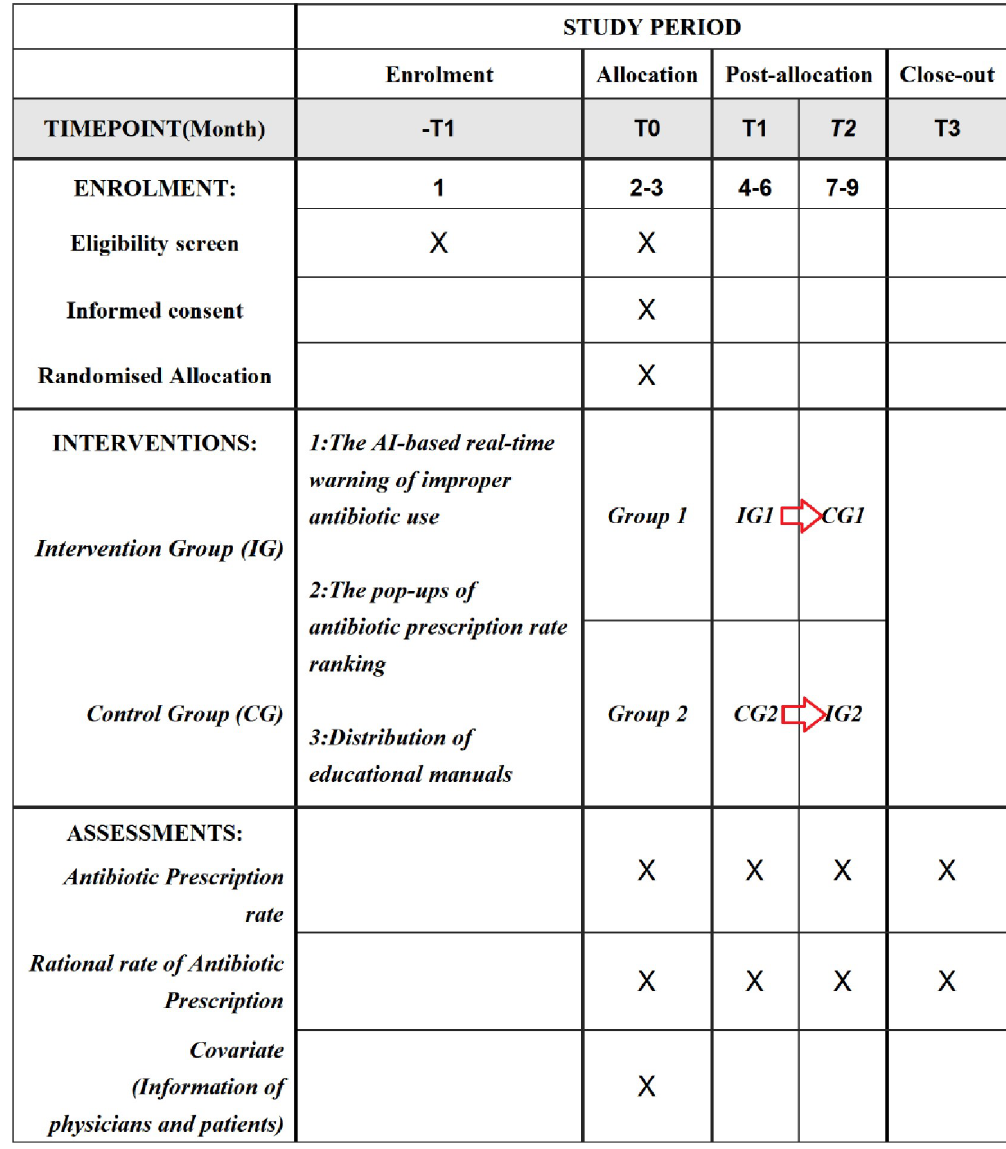
indication; 2. Incorrect antibacterial spectrum: for example, prescribing aminoglycoside